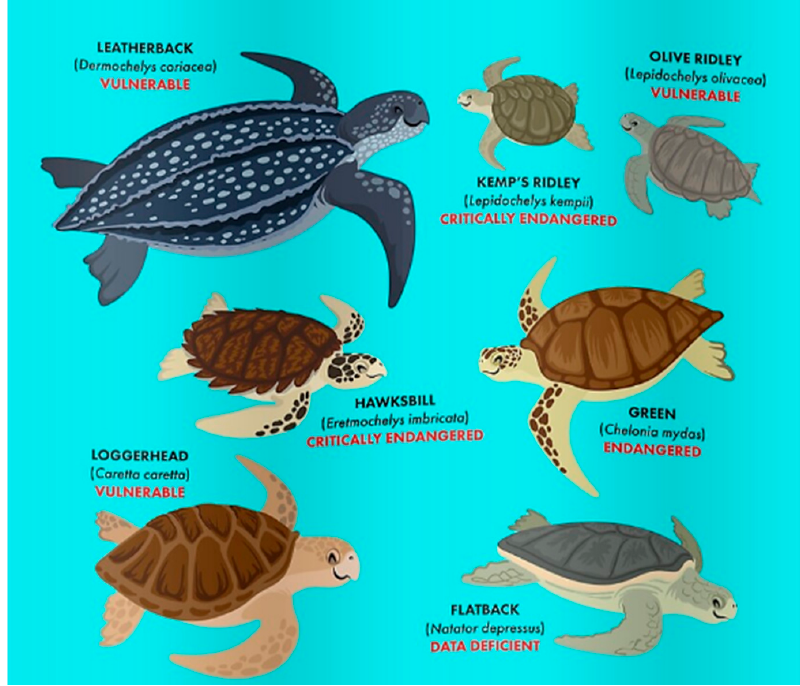
Figure 3. Sea turtle species and endangered risk. Source [40].